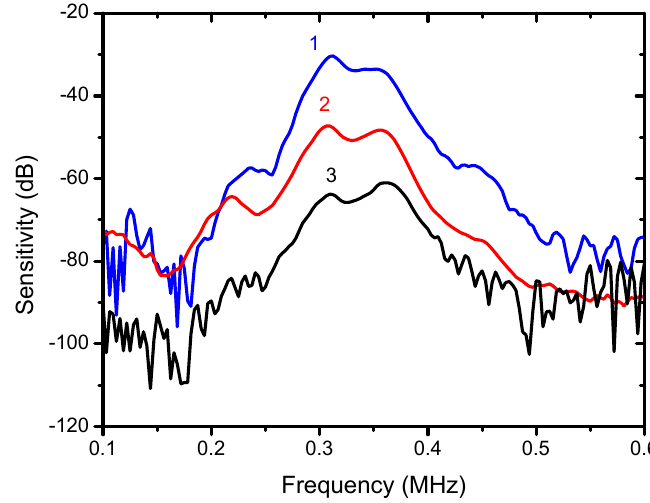
Figure 13. Sensitivity vs frequency for three different operation modes of the transducer. 1: (Blue) Pulse-echo with the 1–3 connectivity composite (6dB-bandwidth 25%). 2: (Red) Pitch-catch, transmit with the 1–3 connectivity piezocomposite and receive with the ferroelectret film (6 dB bandwidth 28%). 3: (Black) Pulse-echo with the ferroelectret film (6-dB bandwidth: